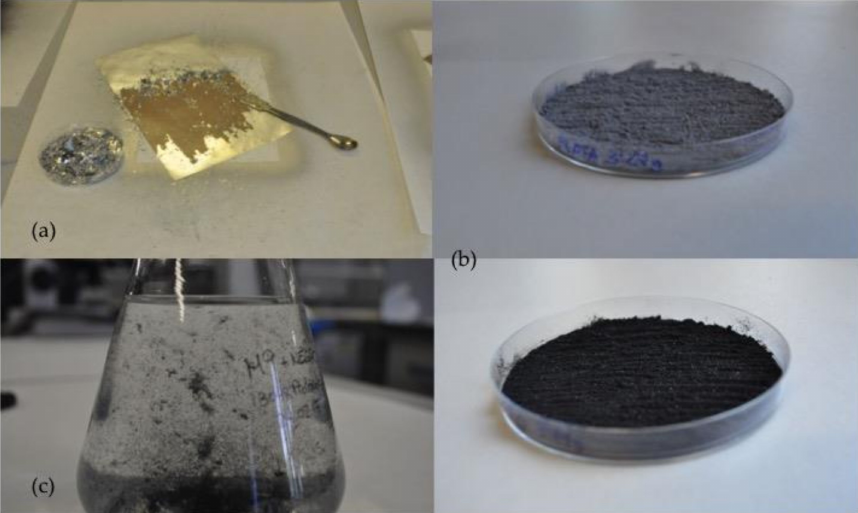
Figure 2. ( a ) Preparation of powdered graffiti; ( b ) silver and black powdered graffiti paints; ( c ) application solution supplemented with black powdered graffiti paint. Protocol 1:1 mL of each bacterial suspension was added to an M9 mineral medium broth enriched with 0.1g/100mL powdered graffiti (black and silver separately) and incubated at 28 ◦ C for 20 days. Protocol 2:1 mL of each bacterial suspension was added to 10% Nutrient Broth (NB) enriched with 0.1g/100mL powdered graffiti (black and silver separately) and incubated at 28 ◦ C for three days. Then, 1 mL of the growing culture was then added to an M9 mineral medium broth enriched with 0.1g/100mL powdered graffiti (black and silver separately) and incubated at 28 ◦ C for 20 days. This is a two-step protocol requiring a growth period of 23